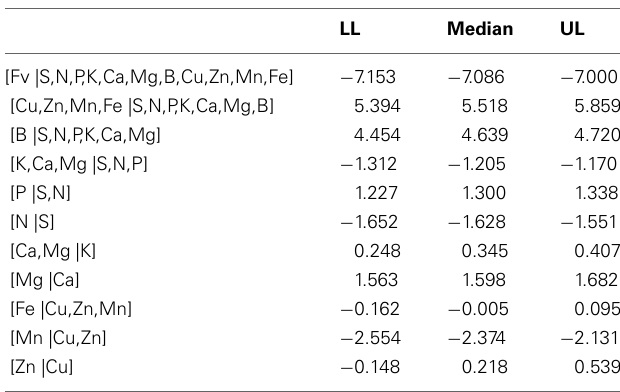
(cid:2) s 2 / n ) for true